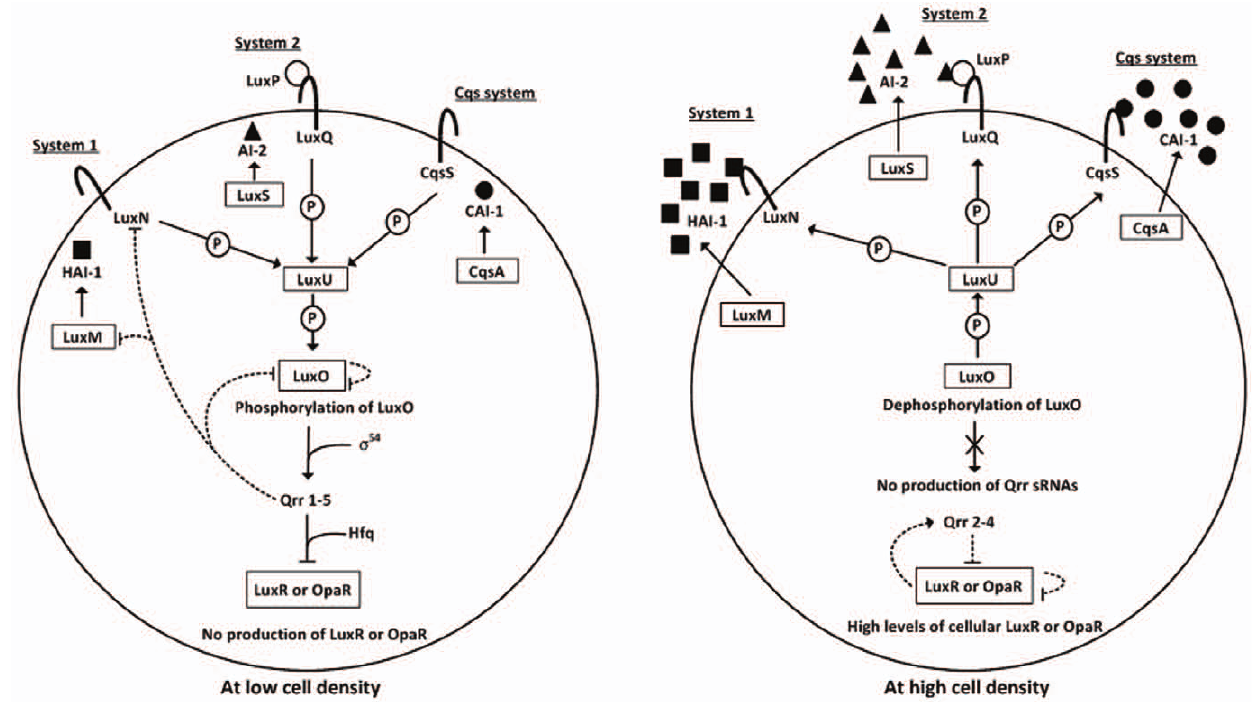
Figure 1. Quorum sensing systems in V.harveyi / V.parahaemolyticus . The mode for signal transduction during QS in V. harveyi has been described in the text. The feedback regulatory loops are shown with dotted lines. Since all the components of V. harveyi quorum sensing appears to be intact in the V. parahaemolyticus genome [16], the QS signal transduction cascades should be conserved in V. harveyi and V. parahaemolyticus .